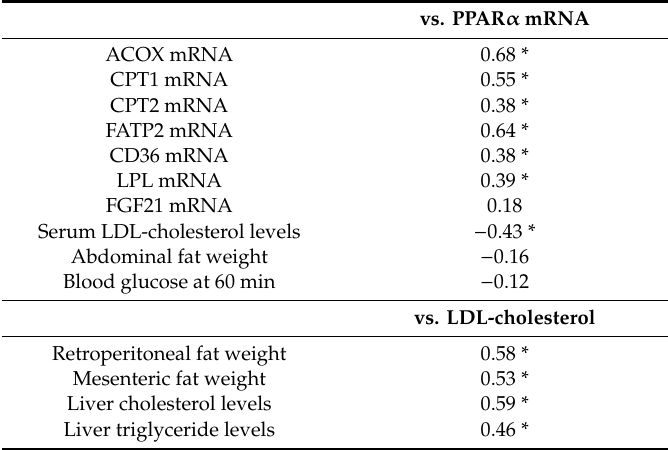
Table 10. Spearman’s rank correlation coefficients for the relationship between PPAR α or LDL- cholesterol levels and parameters related to obesity.